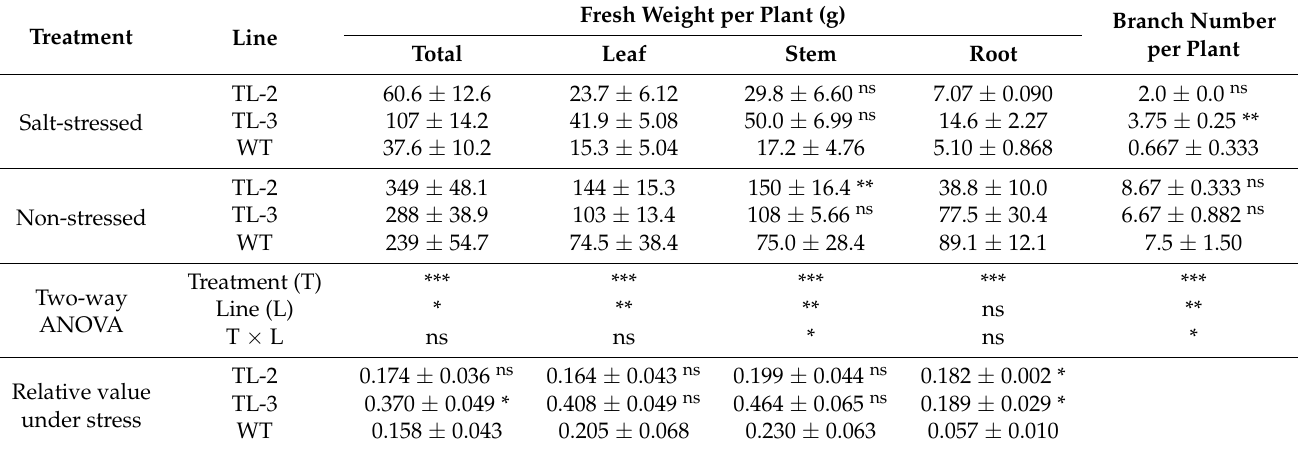
Figure 4. Changes in ( a ) plant height, ( b ) leaflet number per plant, and ( c ) root length in faba bean plants; PR10a transgenic lines TL-3 (green), TL-2 (red), and wild-type faba bean (blue) under non-stressed (circular symbols and full lines) and salt stress conditions (triangle symbols and dashed lines). Data points represent the means ( ± SE) of at least three replicates. Table 1. Fresh weights and branch number of transgenic faba bean lines TL-2, TL-3, and wild-type (WT) after 29 days of salt stress followed by a 14-day recovery period. Relative values of fresh weights under stress compared to the non-stressed condition are also shown. Values are the means ± SE. Asterisks indicate significant differences within treatment by Dunnett’s test using WT as control upon significant interaction indicated by two-way ANOVA. *** p < 0.001, ** p < 0.01, * p < 0.05, ns insignificance with p >